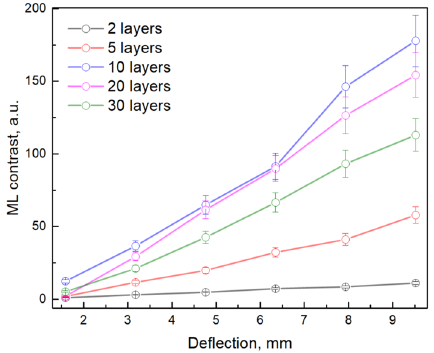
Figure 4. Contrast of ML for samples with N (2, 5, 10, 20, 30) layers changing maximum deflection with an upper estimate of the measurement error of 10%.